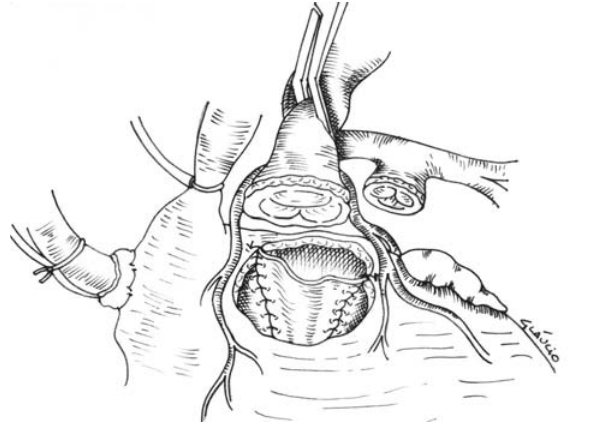
Fig. 2 - Após secção do anel pulmonar e do septo infundibular em direção à comunicação interventricular, realizada ampliação da via de saída do ventrículo esquerdo e fechamento da comunicação interventricular com retalho de pericárdio bovino fixado em glutaraldeído